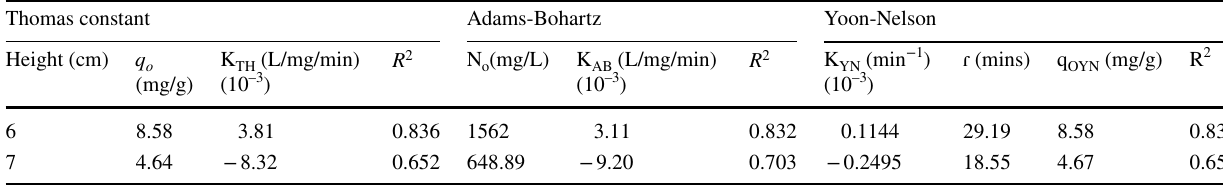
Table 3 Effect of bed height on adsorption model constants Thomas constant